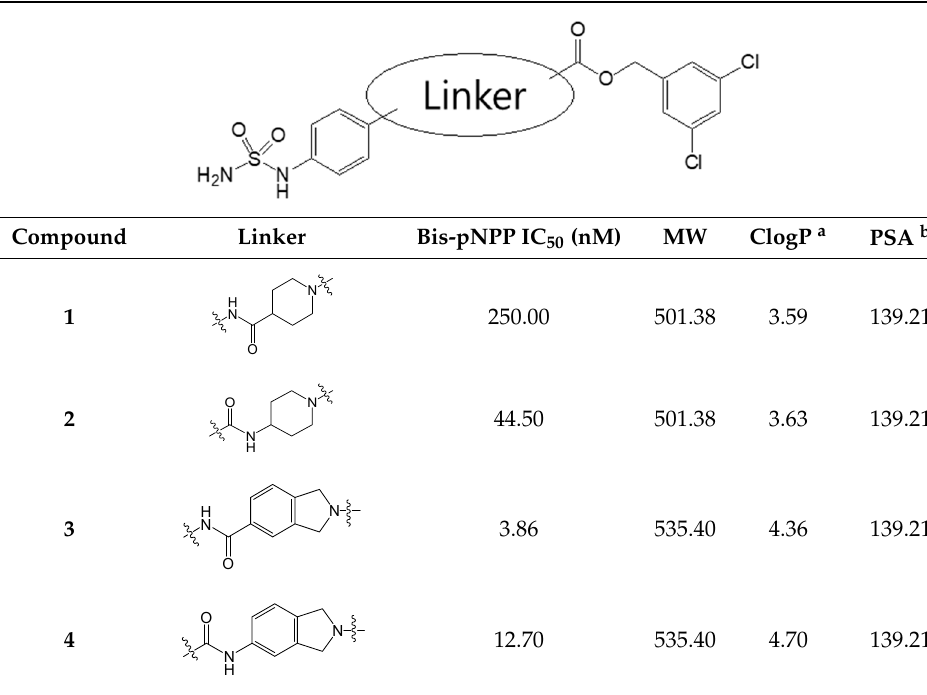
Table 1. Structures, activities, and predicted physicochemical properties of the compounds.